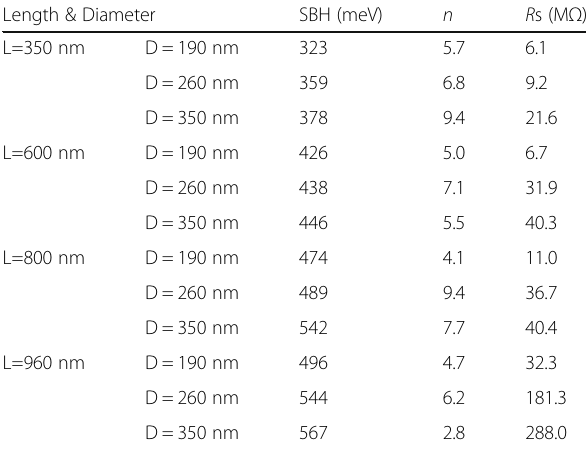
Table 1 Schottky barrier height (SBH), ideal factor ( n ) and series resistance ( R s) obtained from the fitting results of I – V curves obtained on Si NWs with different diameters and lengths Length & Diameter SBH (meV)